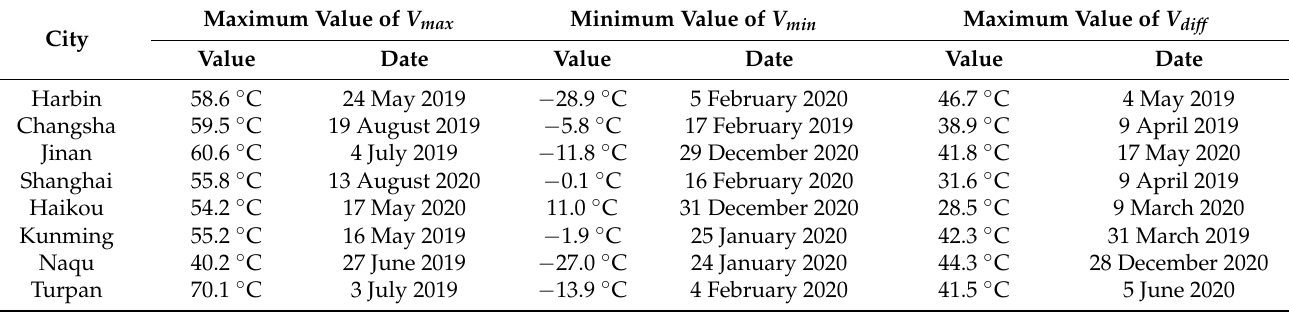
Table 3. Extreme values of steel beam’s V max , V min , and V diff during the whole simulation